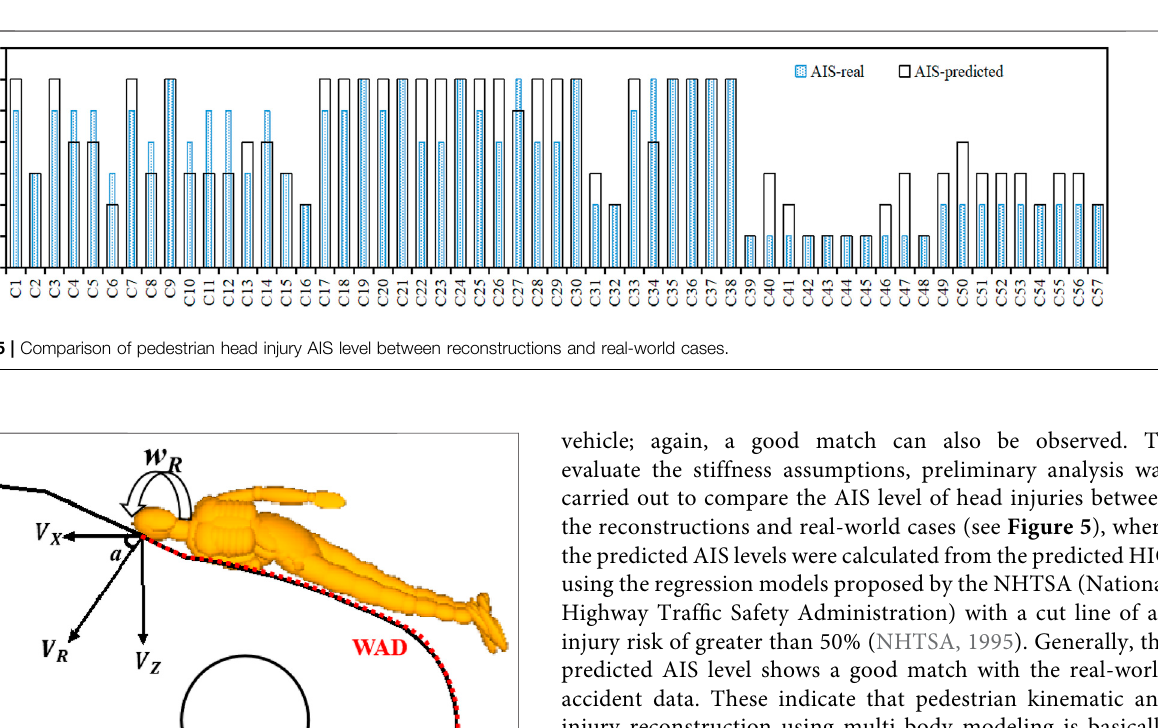
Frontiers in Bioengineering and Biotechnology |